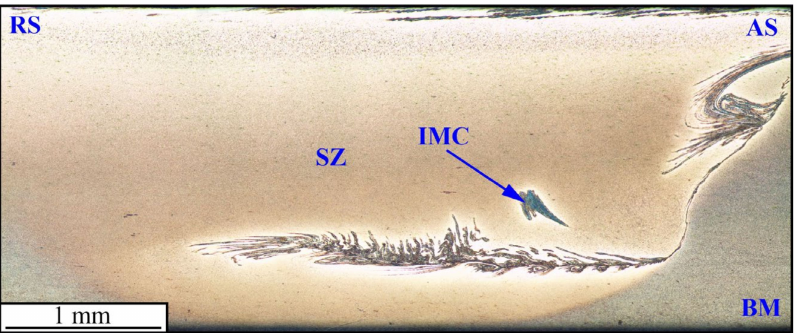
Figure 8. The stir zone image of specimen 3.